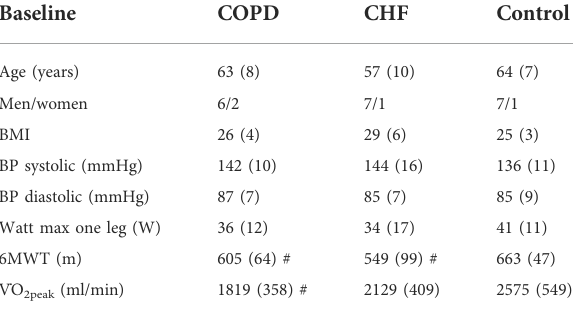
TABLE 1 Subject